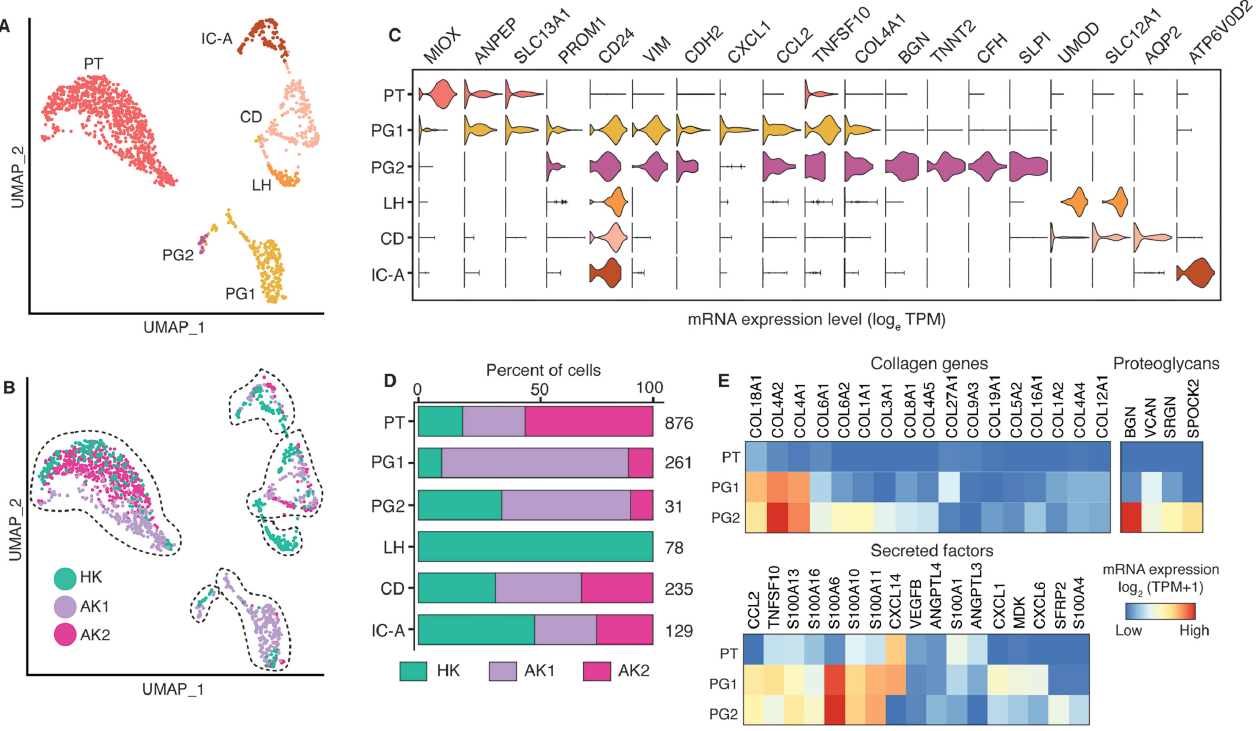
Fig 9. Epithelial cell sub-clustering revealed collagen-producing tubular progenitor cells. (A). UMAP-based visualization of epithelial cells colored by different cell types. PT, proximal tubular cells; IC-A, intercalated cells type A; CD, collecting duct cells; LH, loop of Henle cells; PG, progenitor cells. (B). UMAP-based visualization of epithelial cells colored by the biopsies HK, AK1 and AK2. (C). Violin plot showing expression of the lineage gene markers. (D). Stacked bar plots show the proportion of epithelial cells in each sample. The number on the right is the total number of cells. (E). Heatmap showing top expressed genes belonging to categories of matrisome